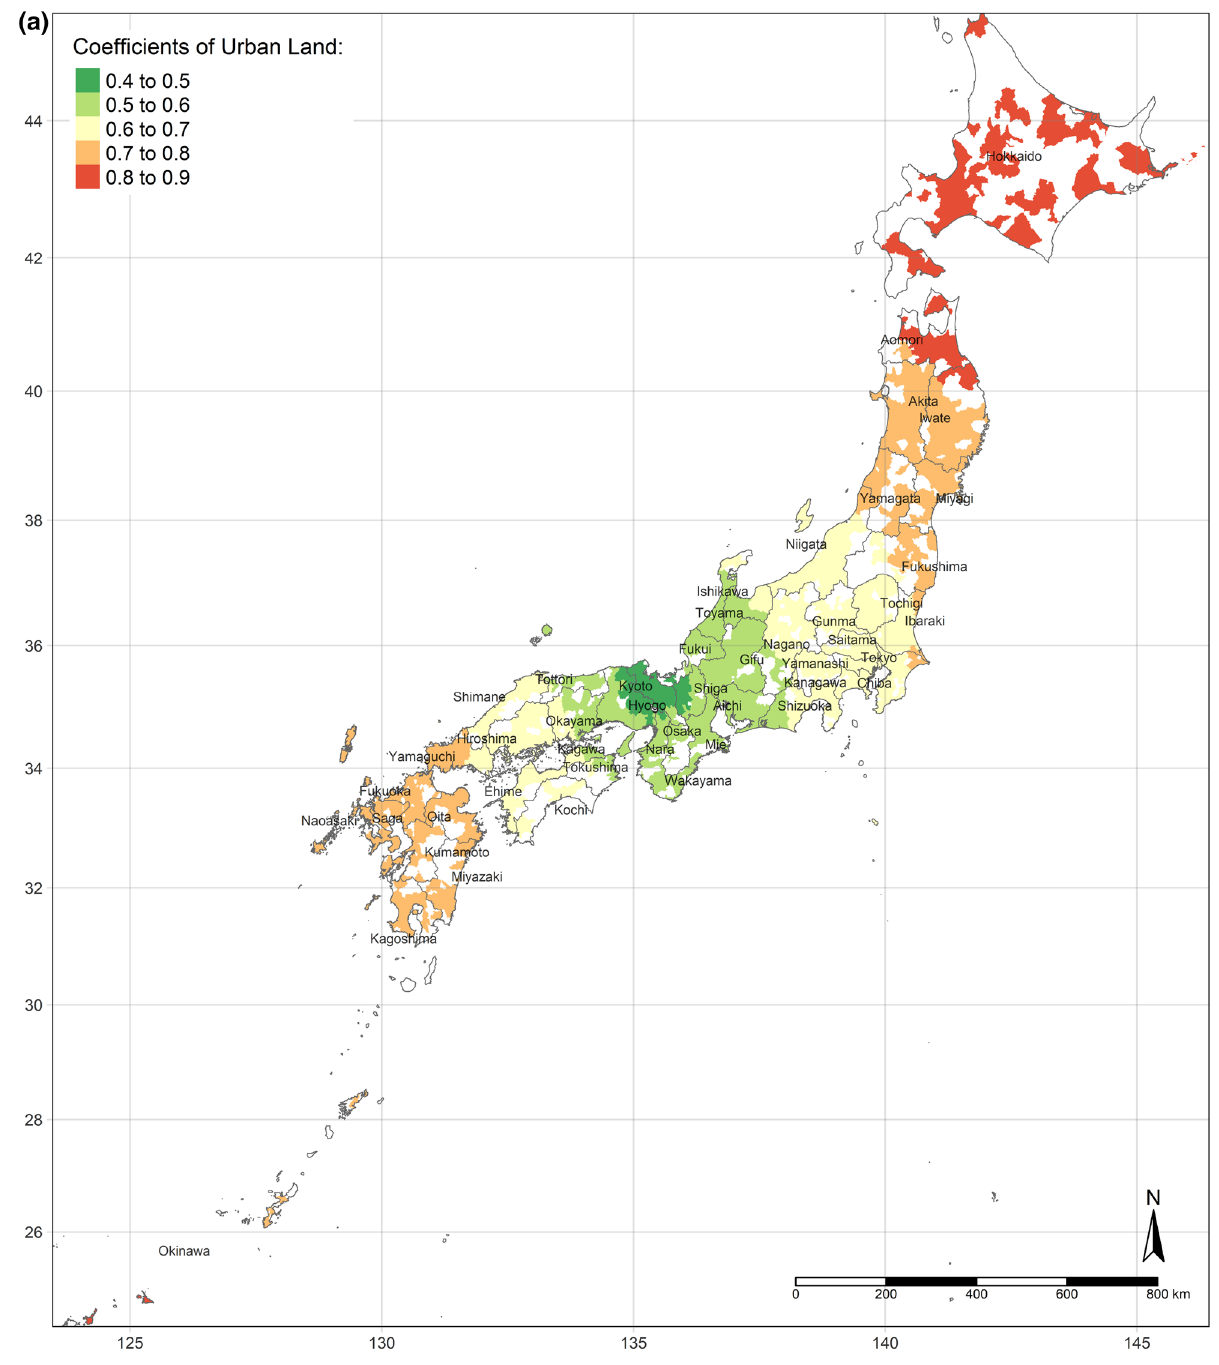
Figure 3. ( a ) Coefficients of urban land. ( b ) Coefficients of water. ( c ) Coefficients of bare land. (Figure a, b, c is created by R 4.0.4, https:// cran.r- proje ct. org/ bin/ windo ws/ base/ old/4.